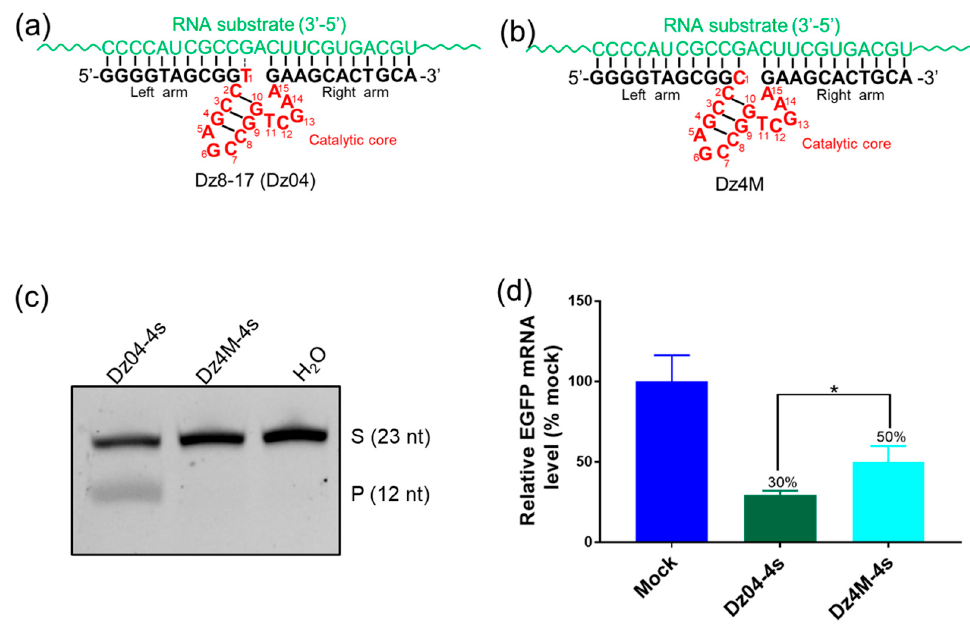
Figure 4. The DNAzyme (Dz04) with both cleavage and antisense activities in cells. ( a , b ) are secondary structures of Dz04, Dz4M and Dz04-4s. ( c ) The in vitro cleavage activities of Dz04-4s and Dz4M-4s under simulated physiological conditions. All reactions carried out in 1.0 µ M Dz8–17, 1.0 µ M substrates, 150 mM KCl and 0.5 mM MgCl 2 at 37 °C for 2 h. ( d ) The cellular mRNA degradation by Dz04-4s and Dz4M-4s was analyzed by RT-qPCR, 24 h after the DNAzyme transfection. Stu-dent’s